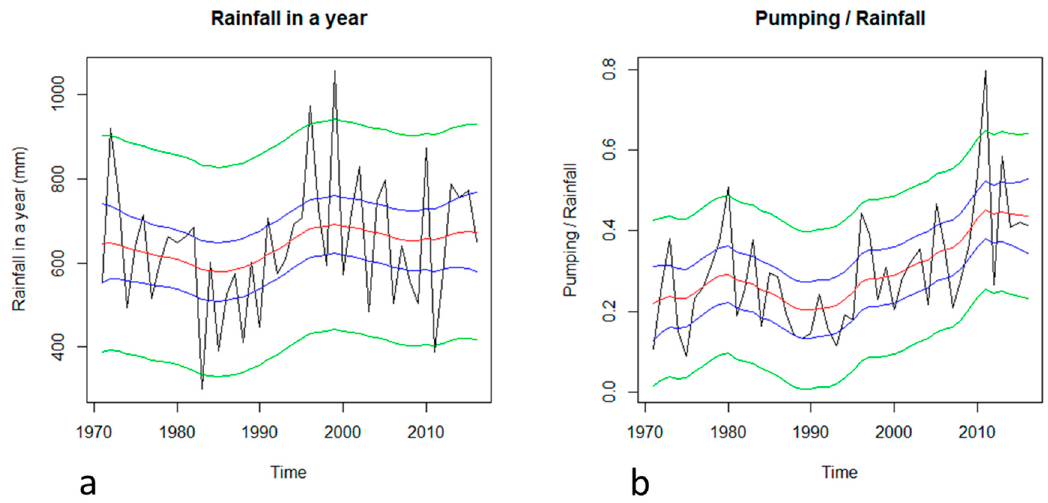
Figure 5. ( a ) Annual drainage (black line) and trend line from space state model (red line) showing the increase in pumping (mm) during the time period considered (1971–2017); ( b ) total days of drainage per year (black line) and space state model trend (red line) over the same period of time. The red horizontal line indicates the maximum (365 days); ( c ) maximum daily pumping per year (black line) and its trend from the space state model (red line) in the period 1971–2017. The blue lines indicate the 90% confidence interval and the green lines indicate the 90% prediction interval for the original model object.